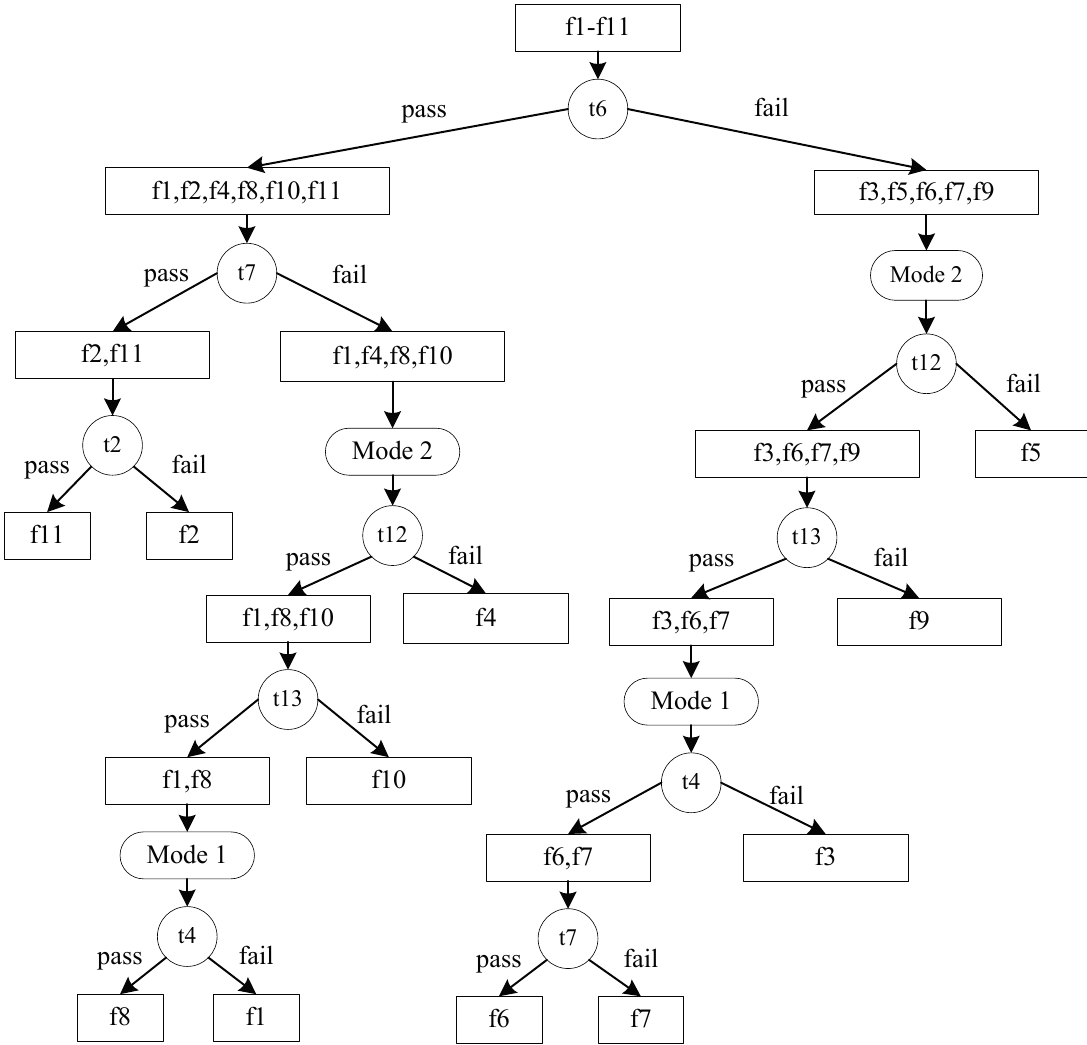
Figure 2. Diagnostic strategy generated by Algorithm